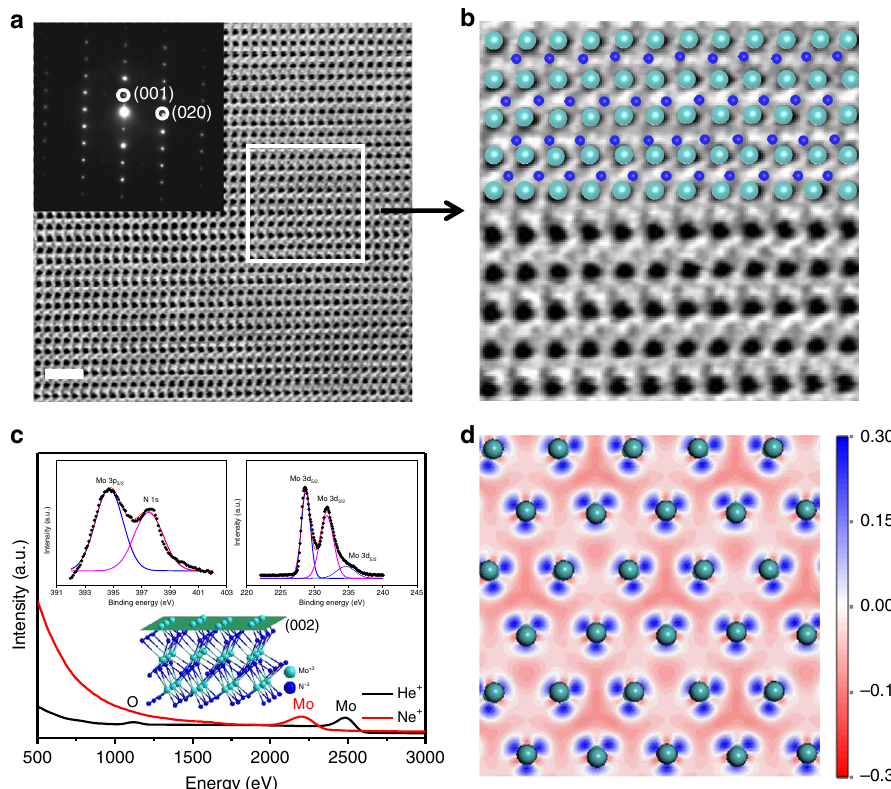
Fig. 3 Crystal structure and chemical state. a Cs-corrected STEM image of the porous single-crystalline MoN. Inset: corresponding SAED pattern of the single-crystalline MoN. b Enlargement of partial Cs-corrected STEM image and the corresponding Mo and N atoms distribution. c HS-LEIS spectra of the outmost surface layer of single-crystalline MoN. Inset: the structure of MoN showing the [002] plane. d Simulated charge density graph of the outmost atomic surface layer of single-crystalline MoN. The dark-blue and light-blue balls represent Mo and N atoms, respectively. The scale bar is 1 nm in panel